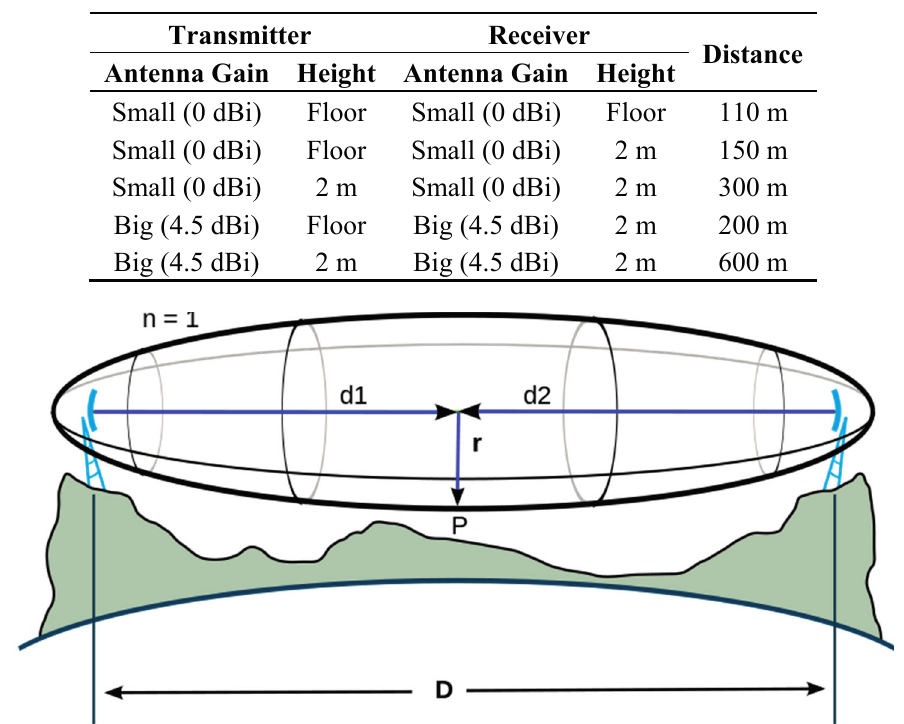
Table 4. Maximum communication range of Xbee 868 MHz.